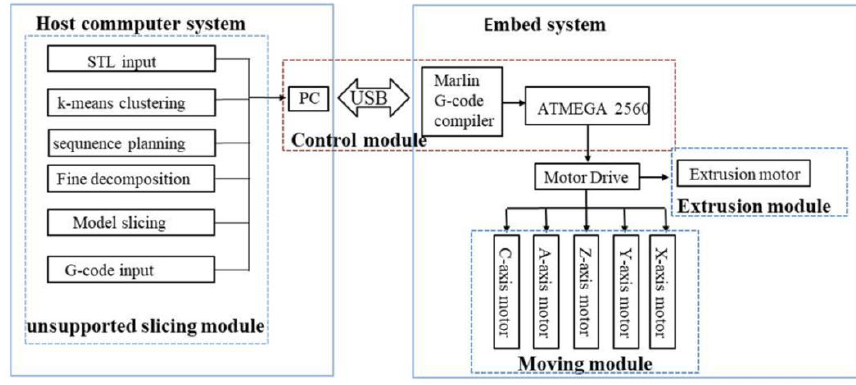
Figure 11. Non-directional unsupported 3D printing system.